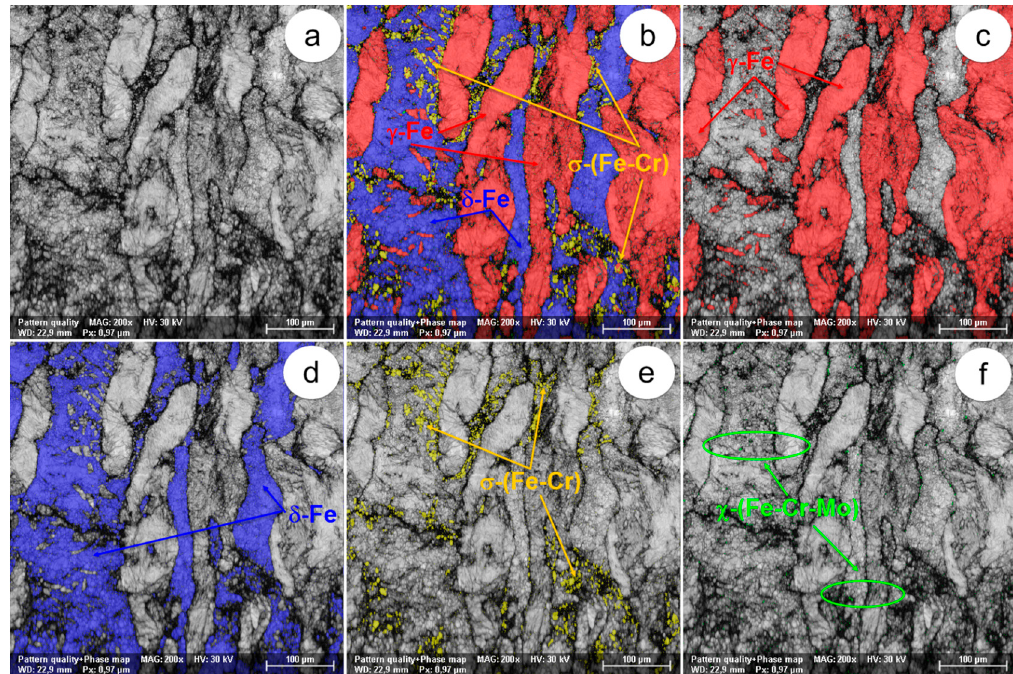
Figure 8. The SEM-EBSD composite images (×200) obtained after forging at 900 °C: ( a ) the microstructure of the analysed field; ( b ) the distribution of existing phases in the microstructure of the analysed field; ( c ) the distribution of the γ -Fe phase; ( d ) the distribution of the δ -Fe phase; ( e ) the distribution of the σ -(Fe-Cr) phase; ( f ) the distribution of the χ -(Fe-Cr-Mo) phase.